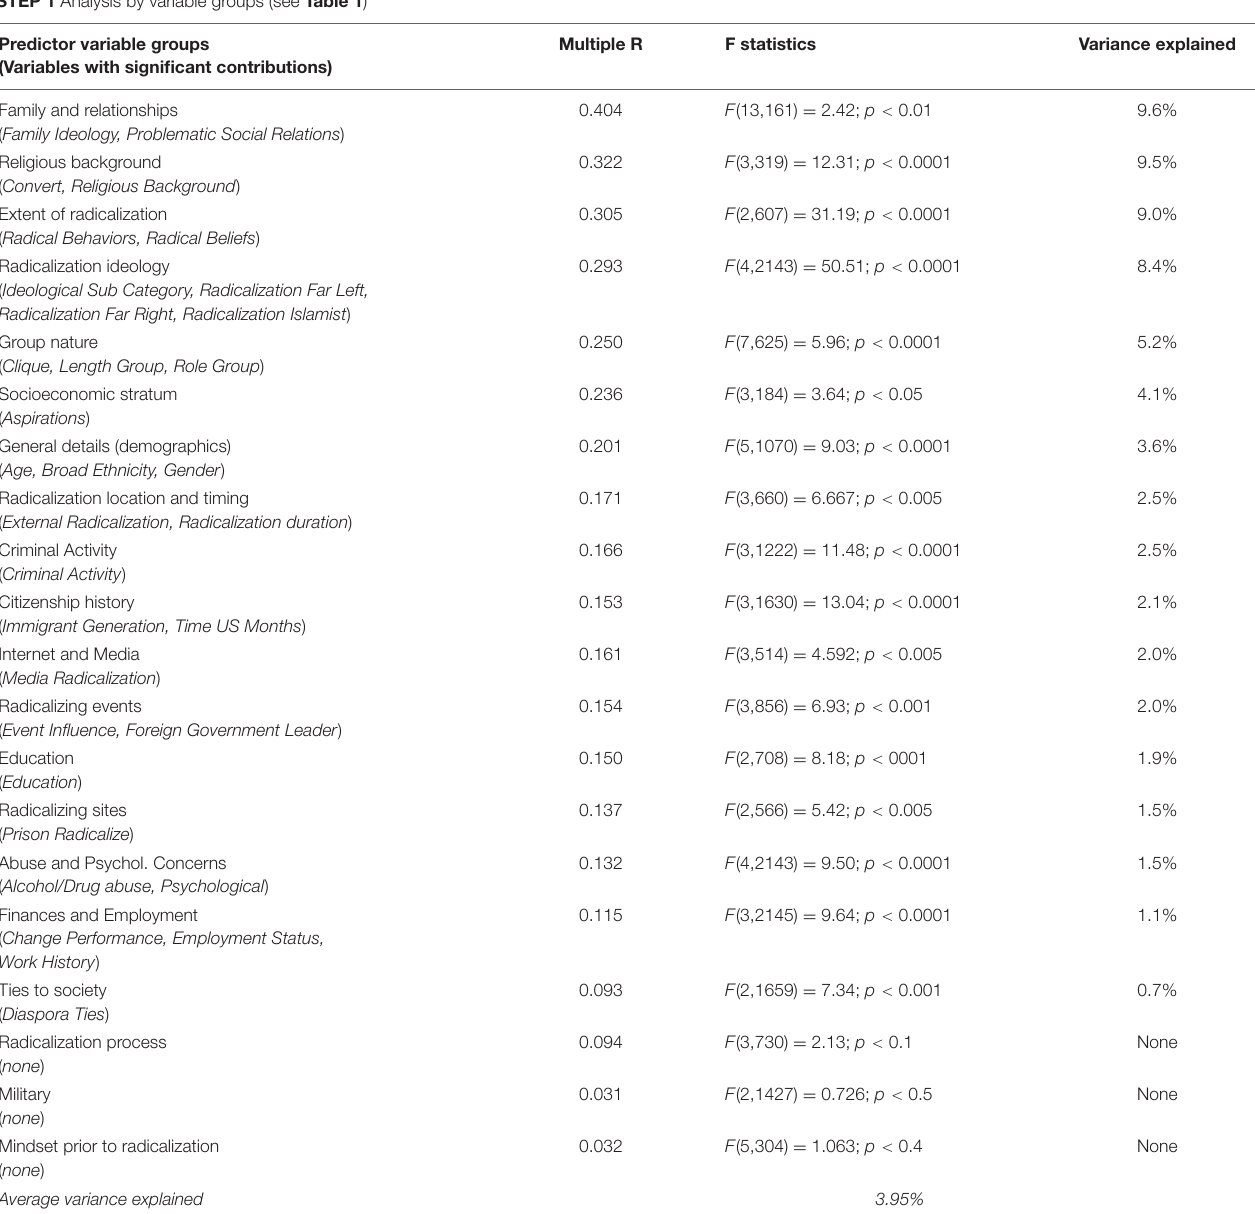
TABLE 2 | Explanations of variance in violence according to the multiple regression